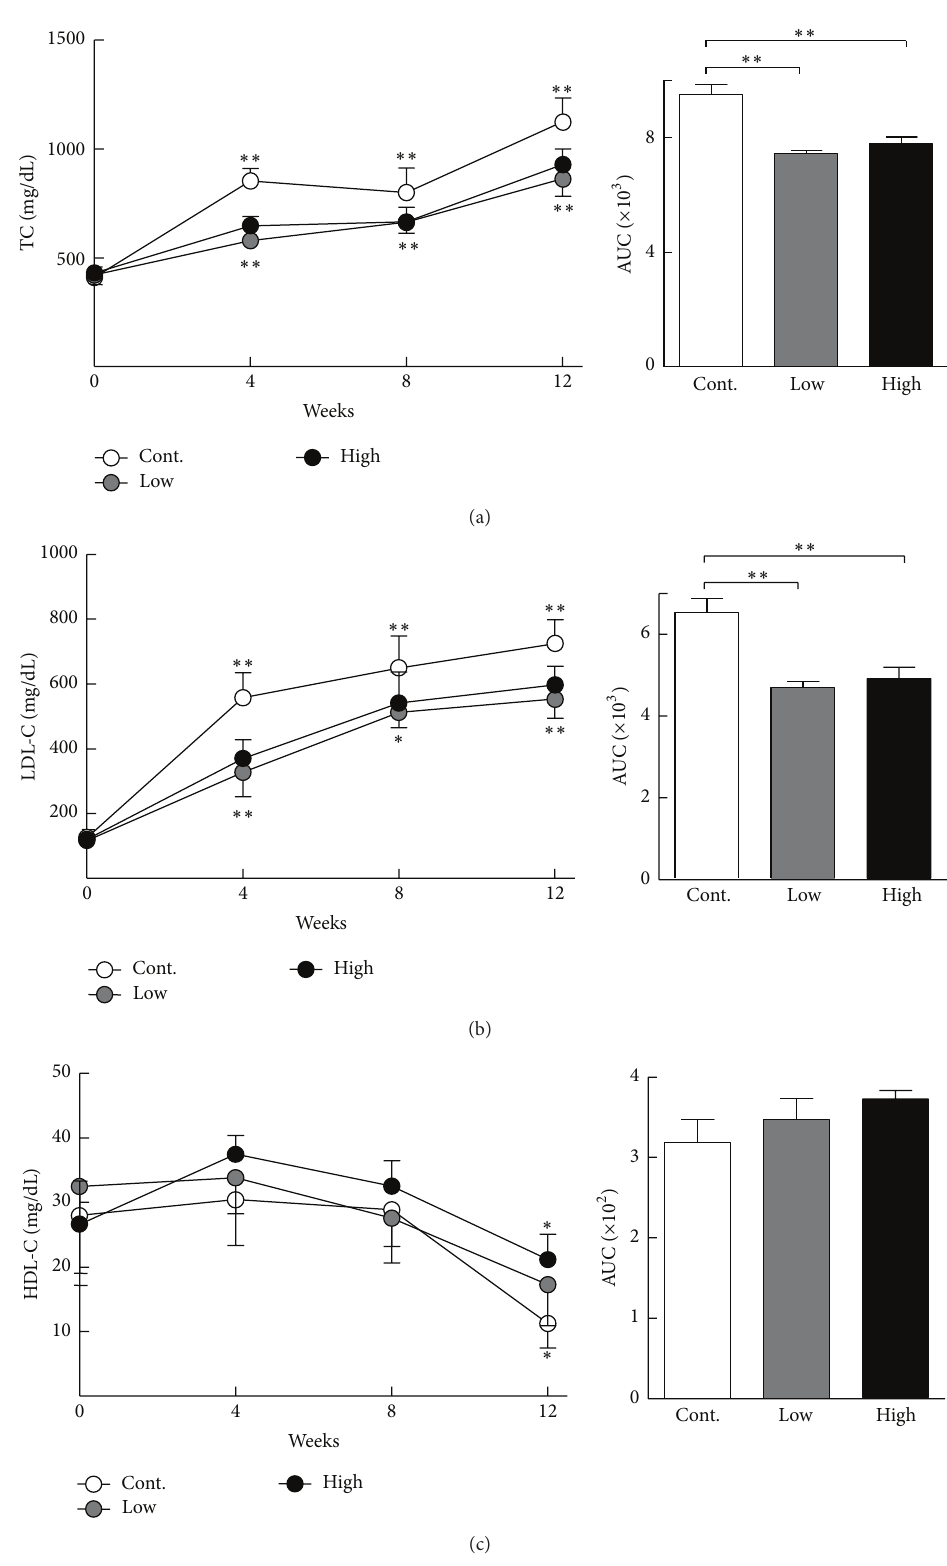
Figure 1: Plasma levels of total cholesterol (TC), low density lipoprotein cholesterol (LDL-C), and high density lipoprotein cholesterol (HDL- C). Data are expressed as the mean ± SEM. 𝑛 = 15 for each group. ∗ 𝑃 < 0.05 , ∗∗ 𝑃 < 0.01 versus